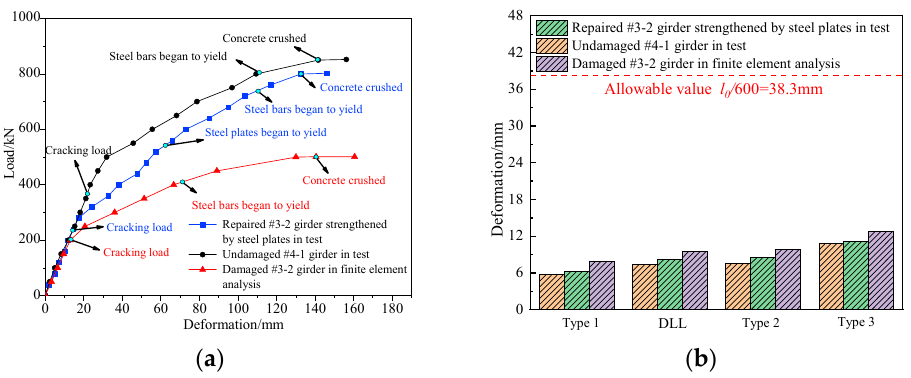
Figure 24. Midspan deformation comparison. ( a ) Load vs. deformation curve; ( b ) Midspan defor- mation under di ff erent live loads.